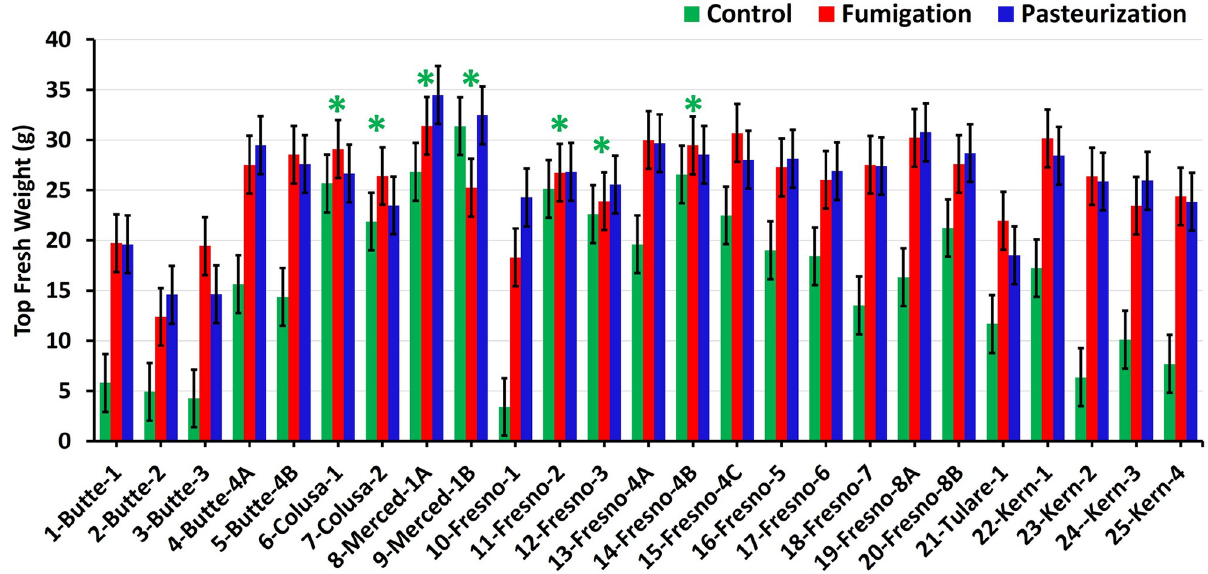
Fig 1. Final top fresh weight of Nemaguard peach seedlings as a function of soil source and preplant soil treatment in greenhouse bioassay. Labels on x axis indicate soil number and county-site, as in Table 1. Error bars are 95% confidence intervals. Asterisks indicate the non-inducing soils.